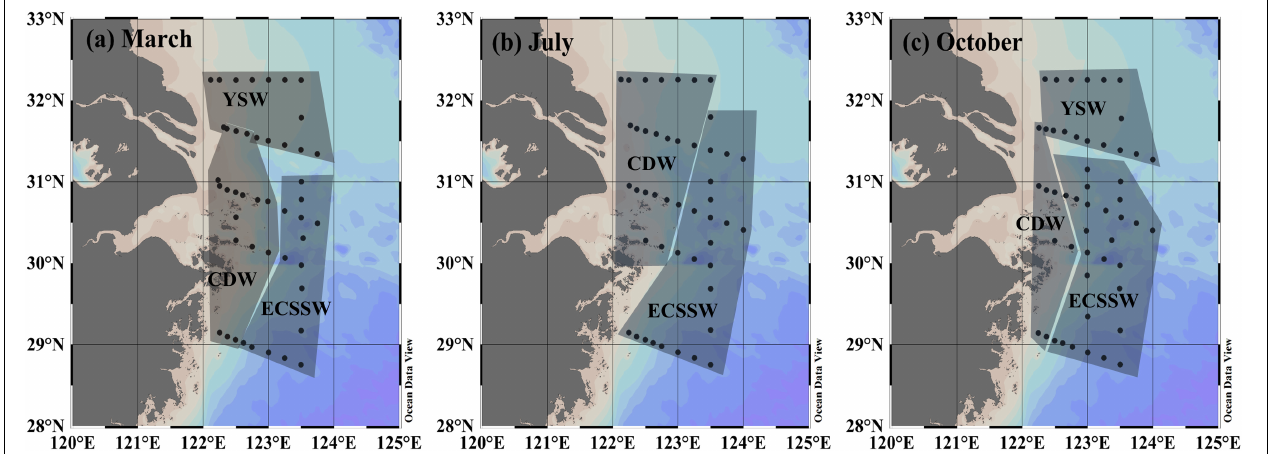
FIGURE 3 | Geographic positions of the three water types in the outer Changjiang estuary in (a) March, (b) July, and (c) October.